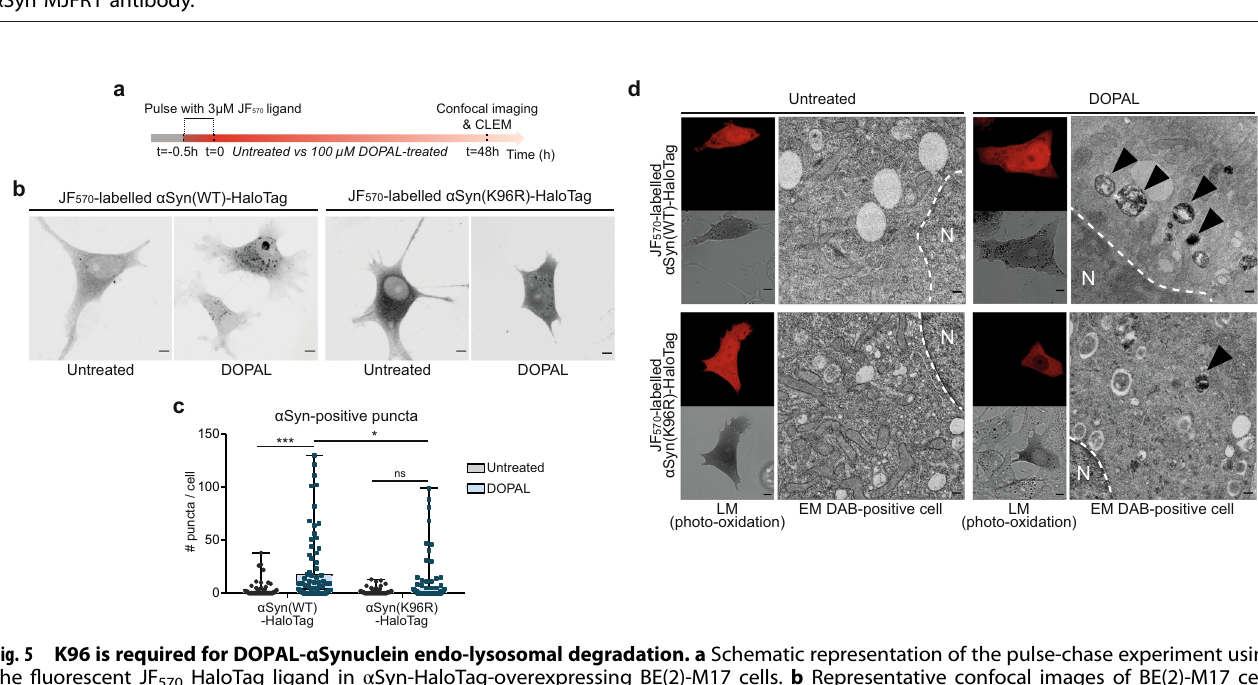
Fig. 4 DOPAL promotes α Synuclein accumulation in the endo-lysosomal pathway and exosomal spreading. a Schematic representation of the pulse-chase experiment in α Syn-TimeSTAMP-YFP-miniSOG-overexpressing primary rat cortical neurons in the presence of 5 µg/ml Nocodazole in the cell medium, − / + 100 µM DOPAL, and b representative snapshots at different time points. Scale bar: 10 μ m. c , d Quanti fi cation of the α Syn fl uorescence variations in the soma and at synapses, where the fl uorescence intensity of each cell body/ synapse is normalized to t = 0. Data are pooled together from three independent experiments (Nocodazole: 32 cell bodies, 2154 puncta; Nocodazole + DOPAL: 23 cell bodies, 2600 puncta), shown as mean ± SEM each time-point, and analyzed by Two-way ANOVA with Bonferroni ’ s multiple comparison test: c interaction **** p < 0.0001, treatment **** p < 0.0001; d interaction **** p < 0.0001, treatment **** p < 0.0001. e In the CLEM experiment in Fig. 2f, representative electron micrographs of MVBs (indicated by the black arrowheads) in non- transfected and α Syn-miniSOG-positive neurons. Scale bar: 100 nm. f Quanti fi cation of ILVs density expressed as total area of ILVs occupied in each MVB. Data are pooled from two independent experiments, three photo-oxidized areas (non-transfected _ untreated: 35 MVBs; non- transfected _ DOPAL-treated: 29 MVBs; α Syn-miniSOG-positive _ untreated: 36 MVBs; α Syn-miniSOG-positive _ DOPAL-treated: 37 MVBs) and analyzed by Two-way ANOVA with Sidak ’ s multiple comparison test (** p < 0.01, **** p < 0.0001). Data are displayed as box and whiskers plot showing the minimum and maximum points (whiskers), the fi rst quartile, median and third quartile (box lines). g CLEM of rat primary cortical neurons expressing α Syn-split-miniSOG. Photo-oxidation of reconstituted α Syn-split-miniSOG in untreated and 100 μ M DOPAL-treated neurons for 24 h (scale bar: 10 μ m), with corresponding electron micrographs of the DAB-positive cell body (N: nucleus; scale bar: 1 μ m) and higher magni fi cation of perinuclear lysosomes and MVBs (scale bar: 100 nm). h Electron micrograph of MVB fused with the plasma membrane (black arrowheads) and α Syn-miniSOG-positive EXs extracellular release. Scale bar: 100 nm. i Immunoblot of cell lysates and exosomal fraction from non-induced and α Syn-overexpressing (100 ng/ml dox) BE(2)-M17- α Syn cells, untreated and 100 μ M DOPAL-treated for 48 h. EXs puri fi cation was assessed by the enrichment in the exosomal markers Alix, HSP70, and Flotillin-1, while α Syn loading was detected by anti- α Syn MJFR1 antibody.